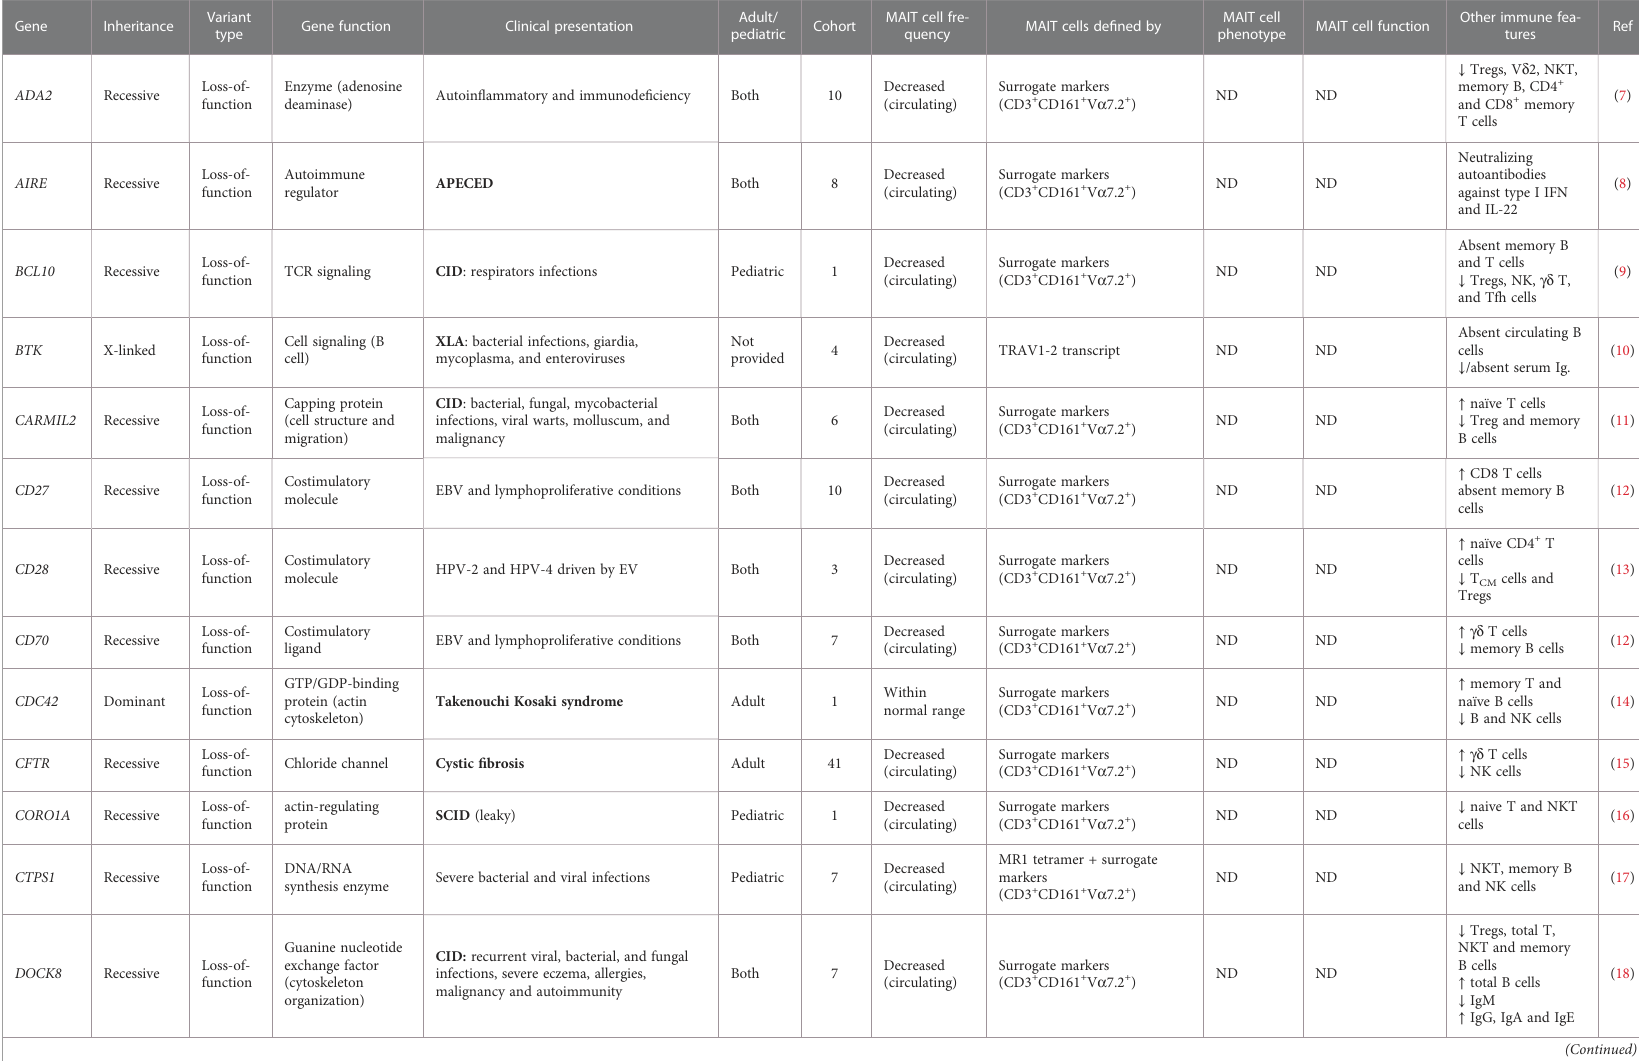
TABLE 1 Summary of inborn errors of immunity that have assessed MAIT cell frequency and/or